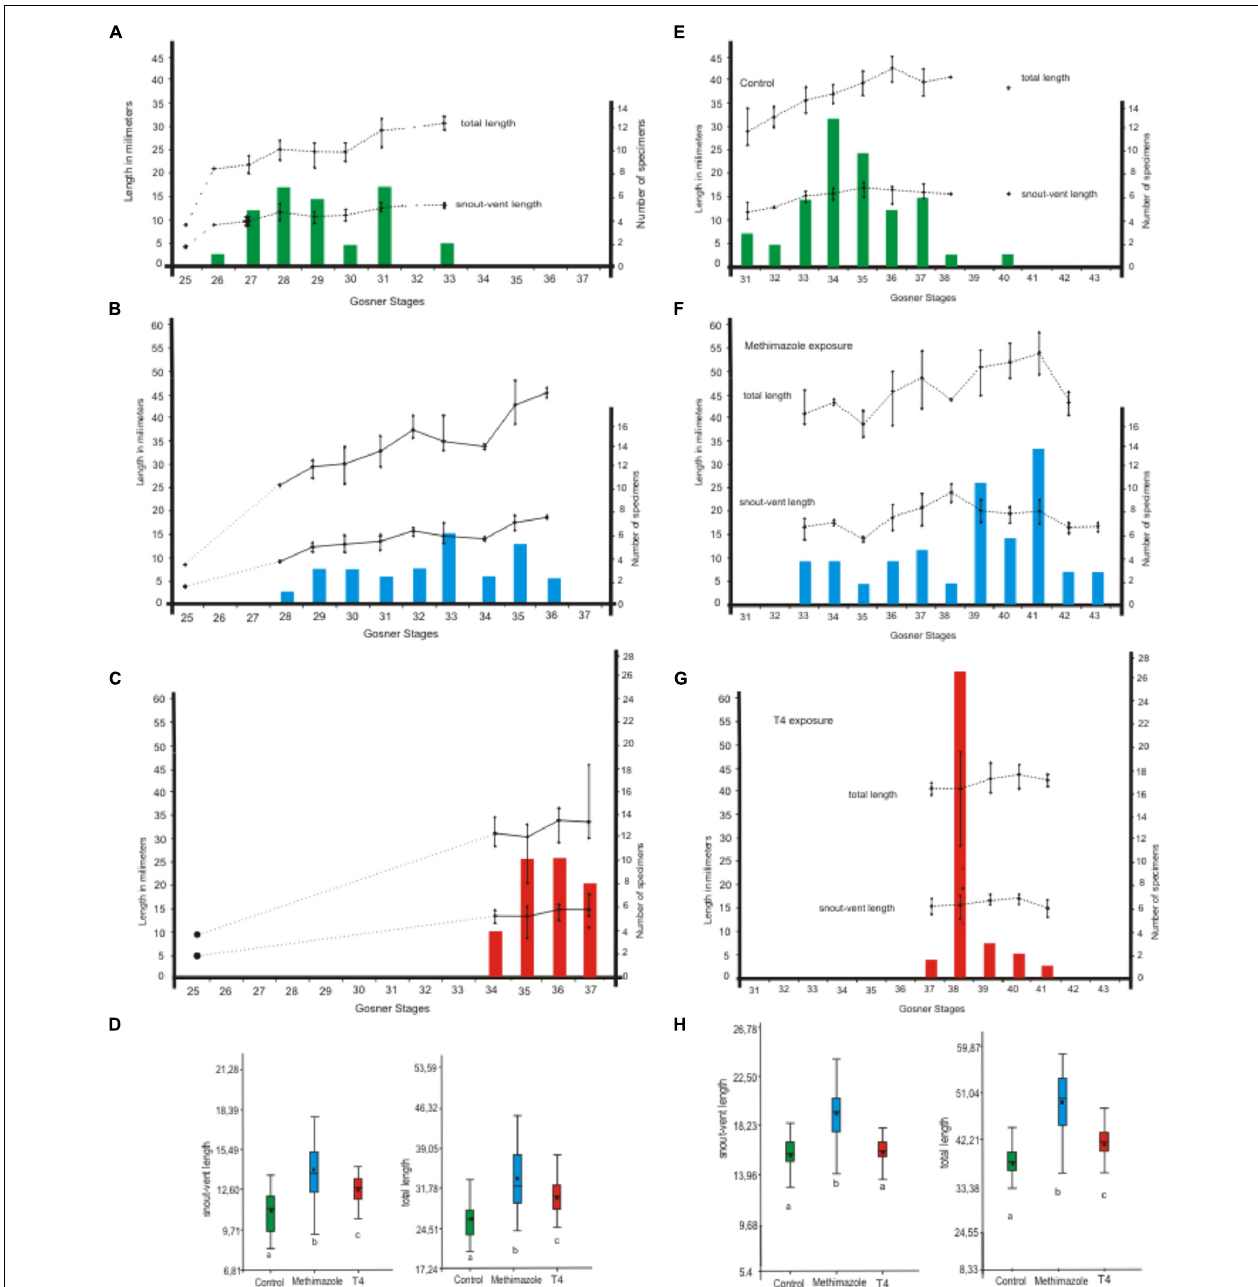
FIGURE 3 | Pleurodema borellii size variation of each larval stage exposed early to methimazole and T4. (A–D) The experiment began with tadpoles in Gosner Stage 25 ( N = 7), with an average snout-vent length of 3.30 mm ( ± 0.35) and an average total length of 8.07 mm ( ± 0.19). Snout-vent length and total length of each larval stage (bars) after 18 days after hatching were measured to determine growth. Simultaneously, tadpoles were also staged. (A) Control specimens. (B) Tadpoles exposed to methimazole (eigth doses). (C) Tadpoles exposed to T4 (eigth doses). (D) Significant differences were found in size variables ( p < 0.05 for snout-vent length and total length) between each treatment and the control. (E–H) Continuity of treatments up to 31 days after hatching (a total of 15 doses). Snout-vent length and total length of each larval stage (bars) at the end of experiments were measured and tadpoles were staged. (E) Control specimens. (F) Tadpoles exposed to methimazole (15 doses). (G) Tadpoles exposed to T4 (15 doses). (H) Significant differences were found in size variables ( p < 0.05 for snout-vent length and total length) between each treatment and the